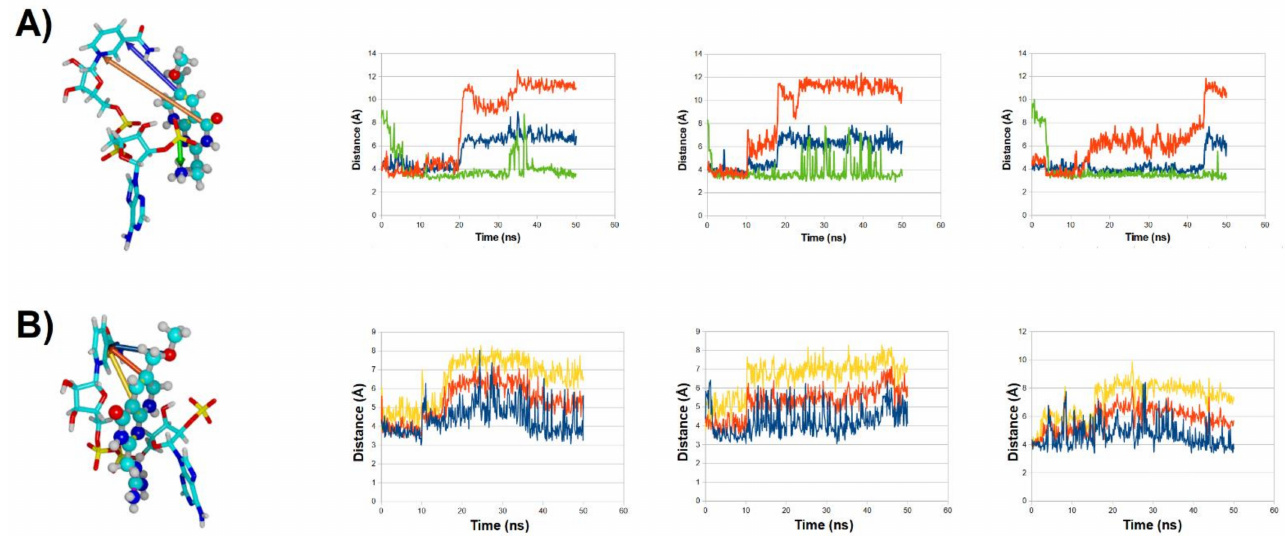
Figure 6. Binding modes and evolution of key ligand-NADPH distances along three molecular dynamics simulations for ligand 31 ( A ) and ligand 32 ( B ). NADPH is depicted as sticks, ligands as solid atom sphere models. Each line in the graph corresponds to the evolution of the distance between the atoms connected with an arrow of the same color in the left-most